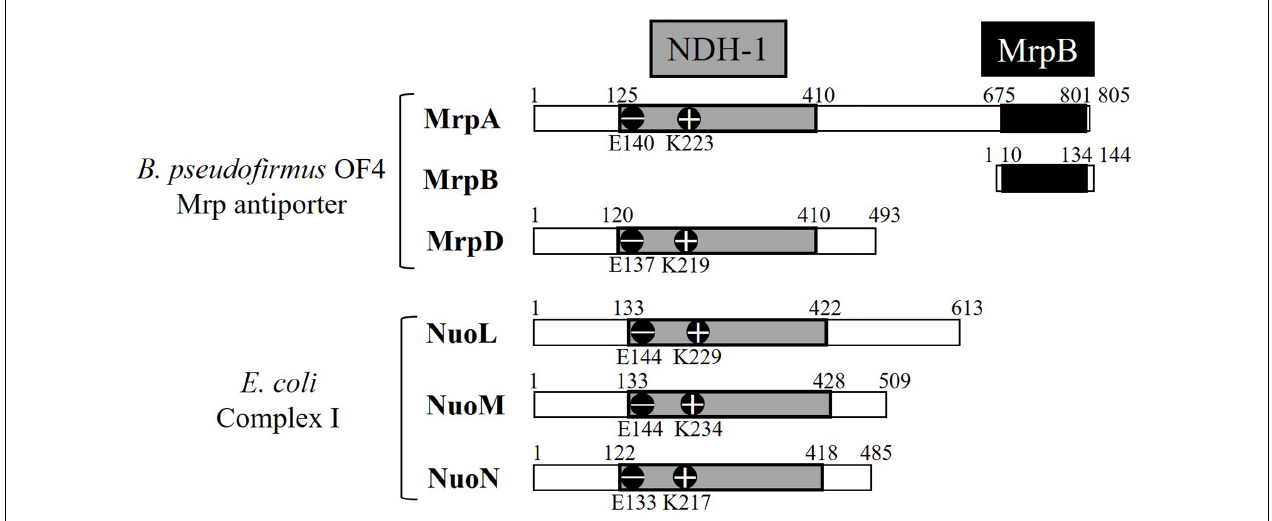
FIGURE 4 | Common regions preserved between the B. pseudofirmus OF4 Mrp antiporter and the E. coli complex I subunit. MrpA, MrpD, NuoL, NuoM, and NuoN proteins having homology to each other are described. The NDH-1 domains conserved among them are represented in gray. The glutamic acid residue (–) and the lysine residue (+) conserved in the NDH-1 region are shown in the schematic. The C-terminal region of MrpA, in black, has been found to be systematically related to the MrpB protein by PSI-Blast analysis (Mathiesen and Hägerhäll,